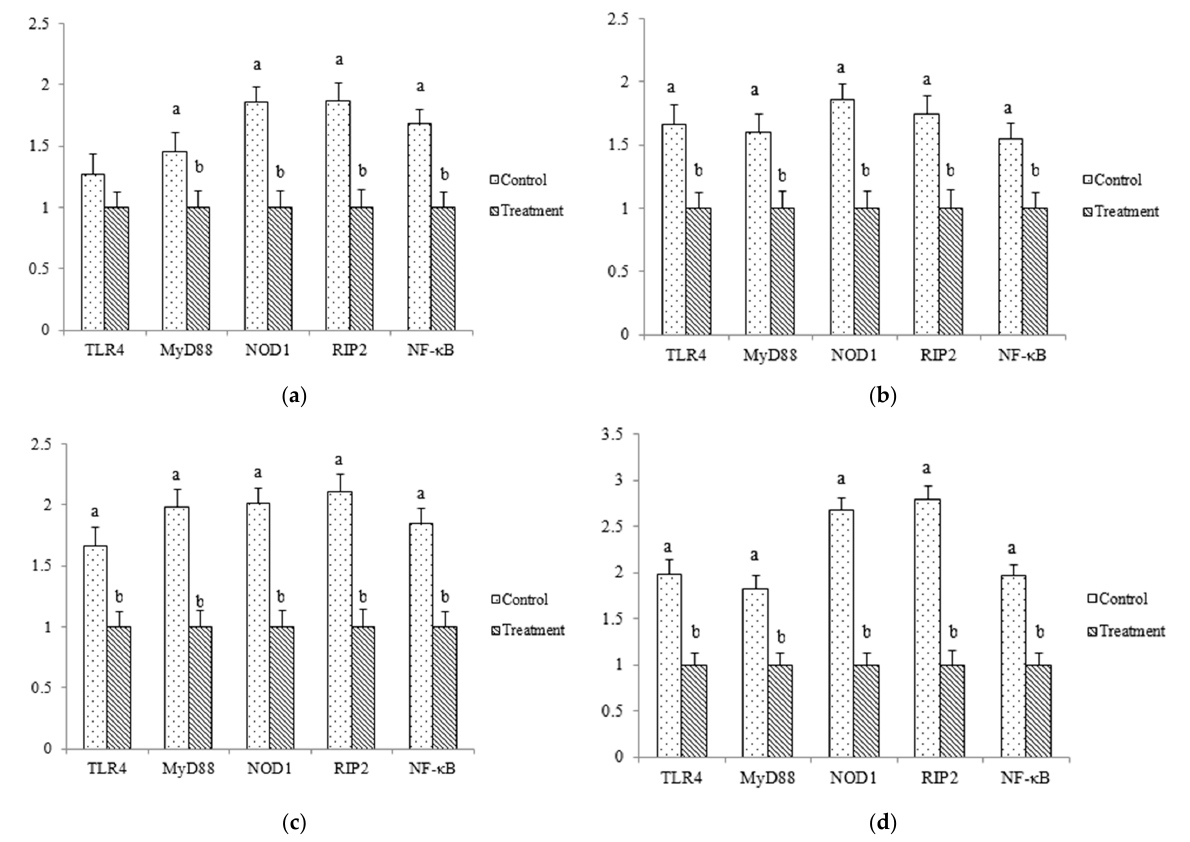
Figure 1. Gene expressions of TLR4, MyD88, NOD1, RIP2, and NF- κ B in thymus of young laying pullets on days 14 ( a ), 21 ( b ), 28 ( c ) and 35 ( d ). Different letters indicate significant differences between mean values for a gene expression ( p < 0.05). TLR4, toll-like receptors 4; MyD88, myeloid differentiation factor 88; NOD1, nucleotide-binding oligomerization domain protein; RIP2, receptor- interacting protein 2; NF- κ B, nuclear factor- κ